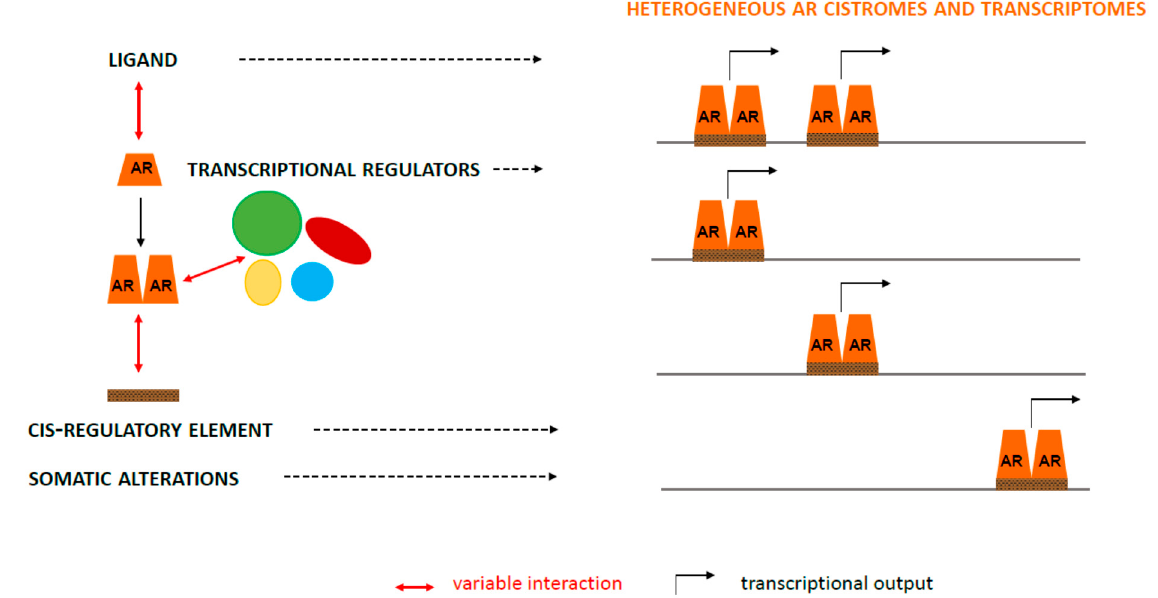
Figure 2. Heterogeneity in AR’s transcriptional output. Variable interactions with ligands (AR monomer), cis-regulatory elements, transcriptional regulators, and somatic alterations (AR dimer) that occur during CaP progression (left panel) lead to markedly different AR cistromes and, ultimately, variability in AR’s transcriptional output (right panel).